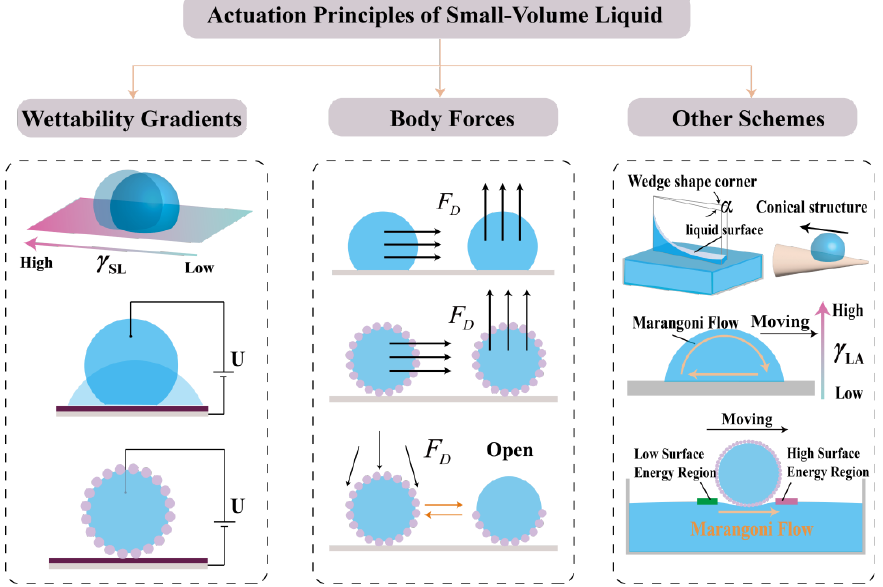
Figure 6. The actuation principles of small-volume liquid, with subcategories of wettability gradients, body forces and other schemes.